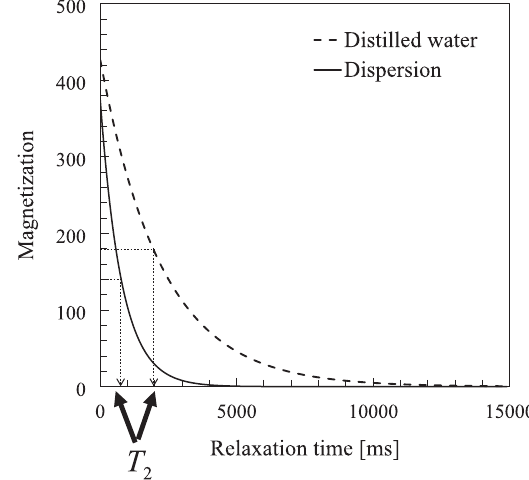
Fig. 1 Typical graph obtained from the NMR based solvent relaxation